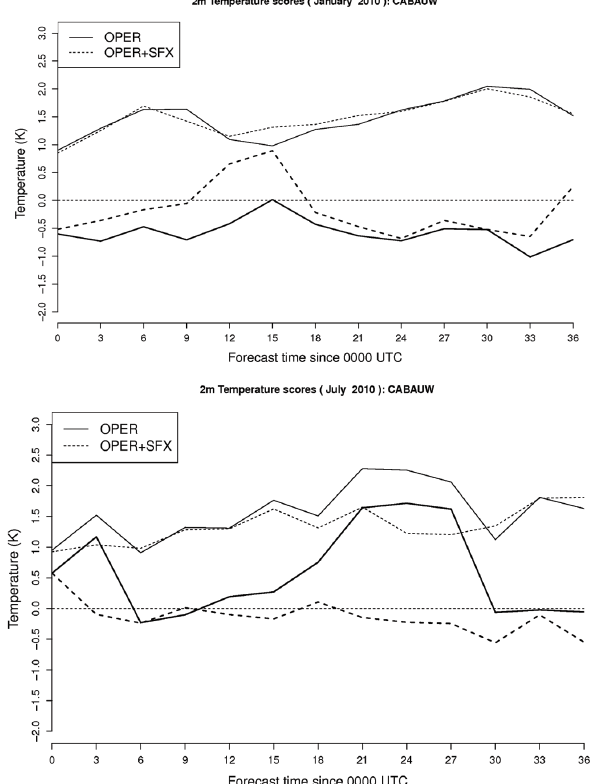
Fig. 9. Statistical scores of 2m temperature against observations at the Cabauw station (bias: thick line; rmse: thin lines) for January (top) and July (bottom) for ALARO without SURFEX (OPER, solid lines) and with SURFEX (OPER+SFX, dashed lines)